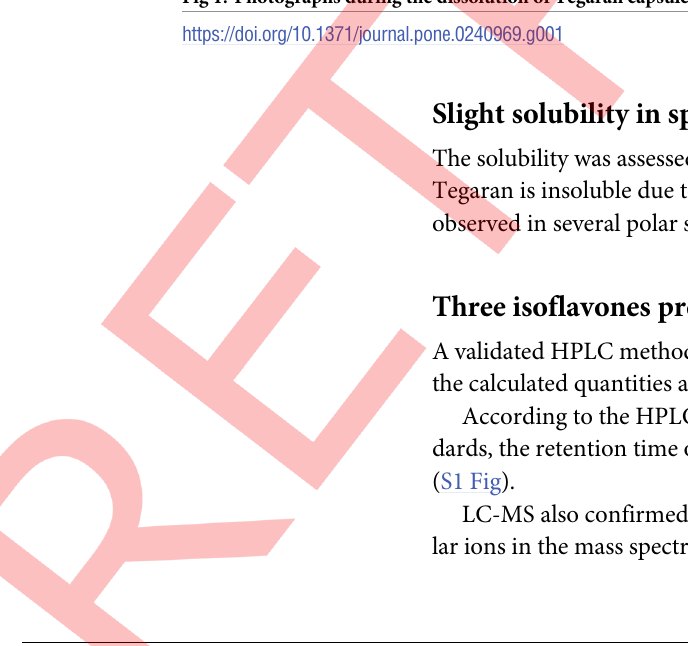
Fig 1. Photographs during the dissolution of Tegaran